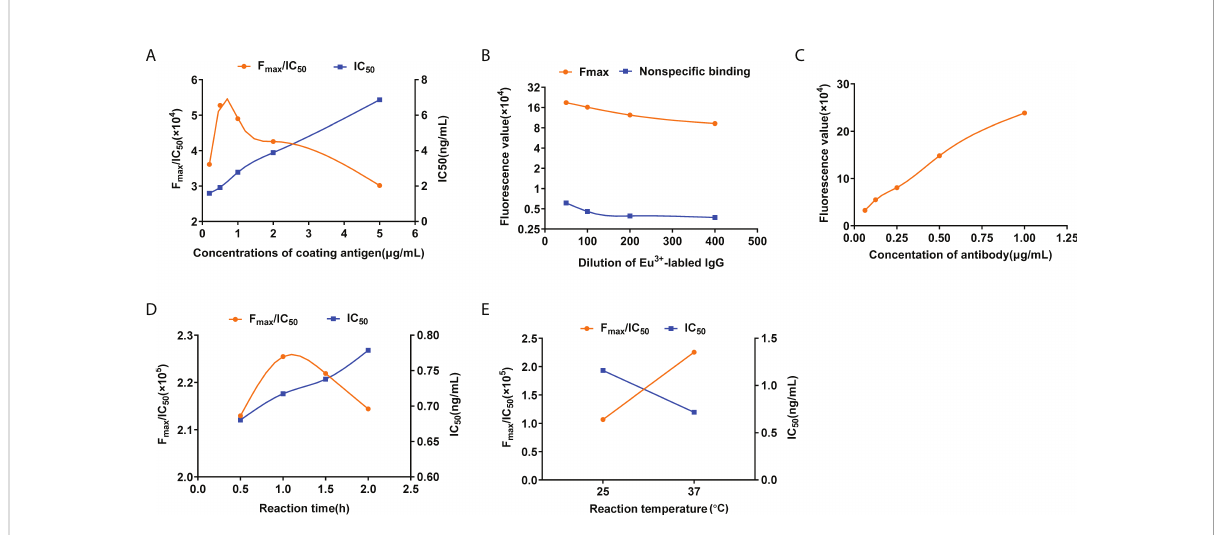
FIGURE 2 Optimization conditions of OA-TRFIA. (A) F max /IC 50 values and IC 50 values in different coating antigen concentration. (B) Maximum fl uorescence values and non-speci fi c binding fl uorescence values at different Eu3+-labeled antibody concentrations. (C) Fluorescence valuesin different antibody concentrations. (D) F max /IC 50 values and IC 50 values in different incubation times. (E) F max /IC 50 values and IC 50 values in different incubation